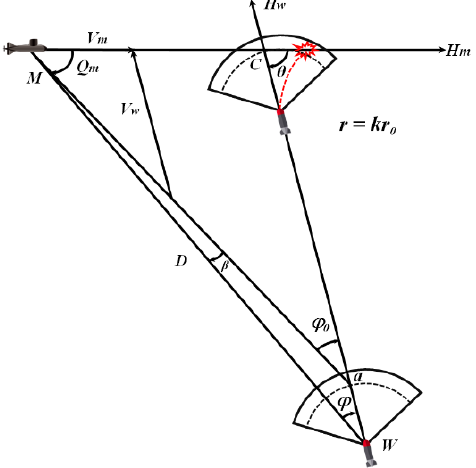
Figure 1. The diagram of torpedo firing advance angle calculation.